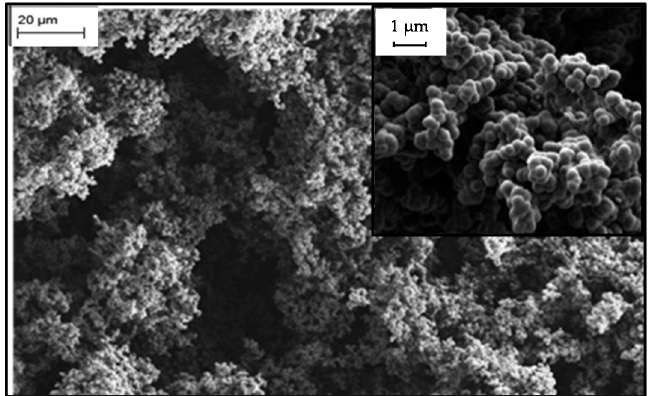
Figure 2. Microstructure of lf-C aerogel with an average particle size of about 0.36 µm and average pore size of about 71 nm.